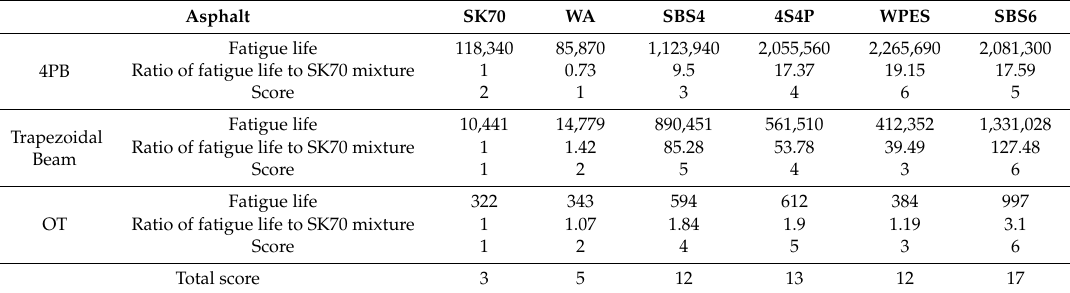
Table 5. The fatigue life and score of di ff erent asphalt mixtures in di ff erent fatigue